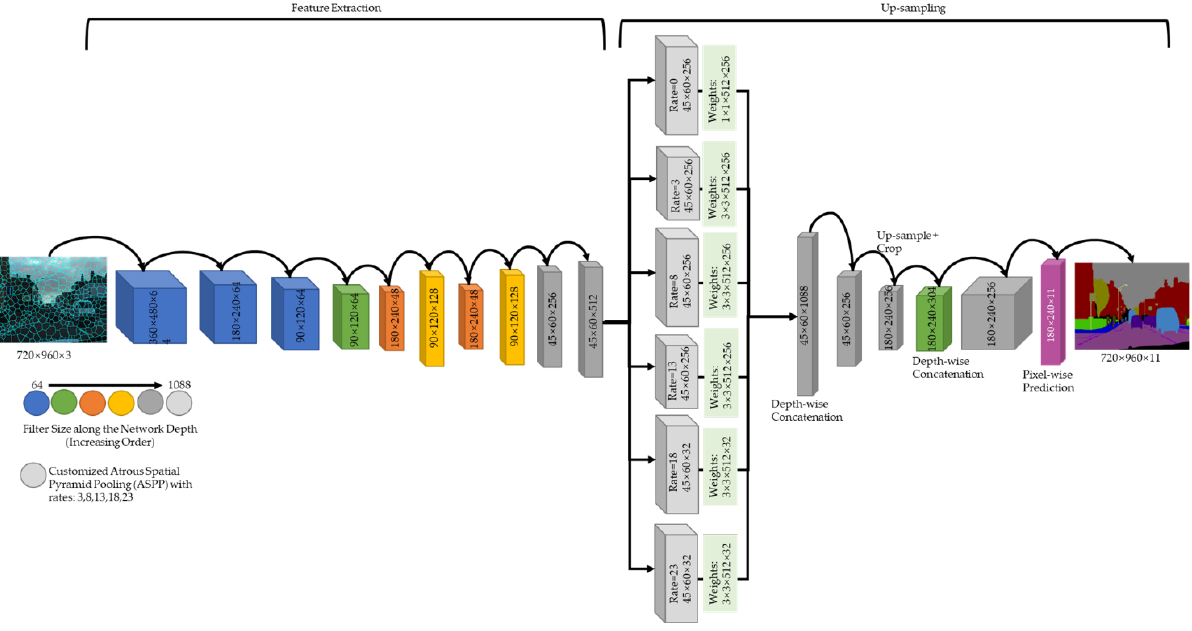
Figure 5. Customized Decoder Module for Semi-dark Images.